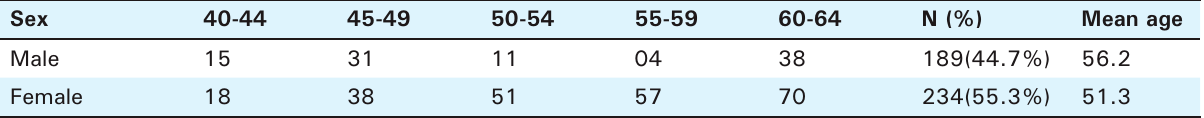
Table 1. Distribution of study population according to sex and age